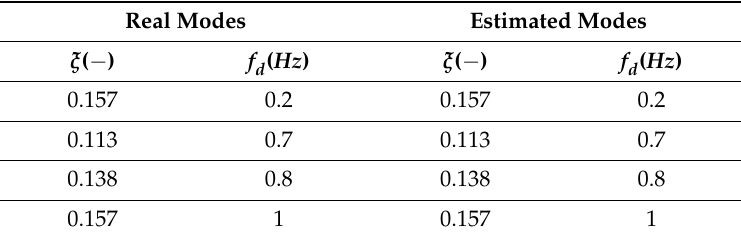
Table 2. Calculated Modes of Test Case 1.